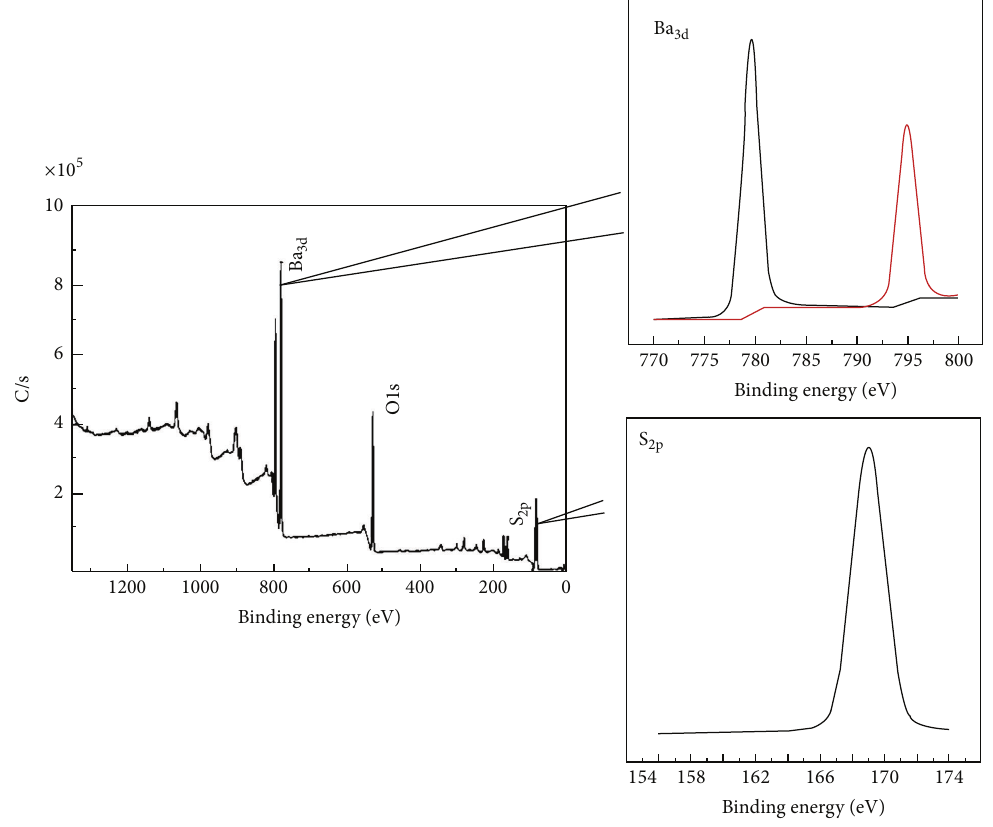
Figure 7: XPS spectrum of all elements of barite and XPS spectrum of Ba and S.